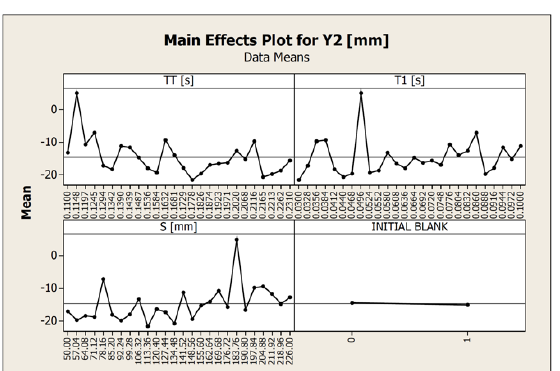
Figure 22. MEP for Y1 output.